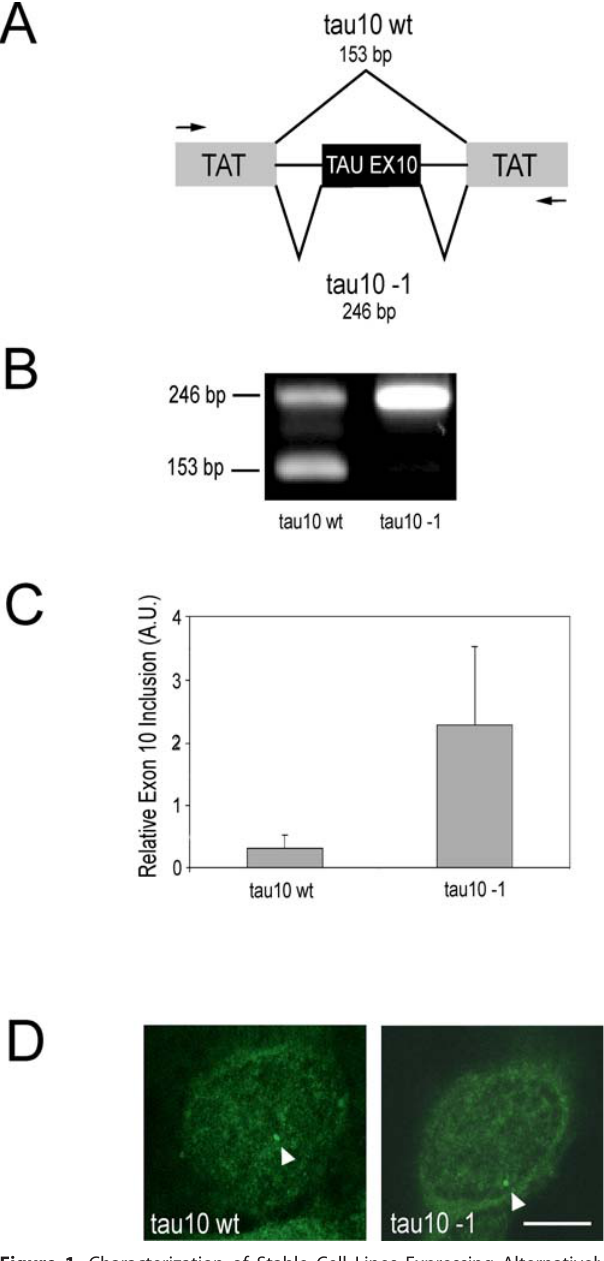
Figure 1. Characterization of Stable Cell Lines Expressing Alternatively Spliced tau Minigenes (A) Schematic representation of the tau exon 10 minigene system. Alternative inclusion or exclusion of exon 10 as observed for endogenous tau is recapitulated in a minigene containing flanking HIV-TAT exons. (B) Preferential inclusion of tau exon 10 detected by gel electrophoresis. The wt tau exon 10 (tau10wt) is evenly included or excluded from the mRNA, whereas a tau exon 10 containing a T . C mutation at position (cid:1) 1 of exon 10 (tau10 (cid:1) 1) is predominantly included in the same context. Exon 10 inclusion is detected as a 246-bp by RT-PCR using primers (arrows) in the TAT exons. Exon 10 exclusion is detected by a 153-bp band. (C) Quantitative real-time PCR analysis to determine exon 10 inclusion. Results are averages 6 standard deviations from at least three experiments. (D) RNA-FISH using nick-translated probes against the tau minigene to detect sites of tau transcription. The vast majority of cells in a stable cell population contained one or two tau minigene insertion sites. Arrow- heads indicate tau transcription sites. Scale bar ¼ 3.5 l m. DOI: